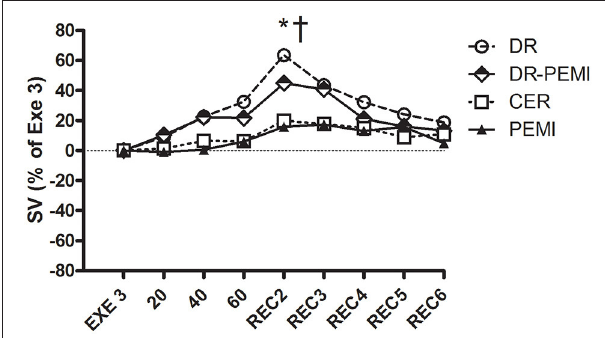
FIGURE 2 | HR time courses during all four tests. Values are means ± SD percentages of the end of handgrip (EXE3). * = P < 0.05 vs. EXE3.